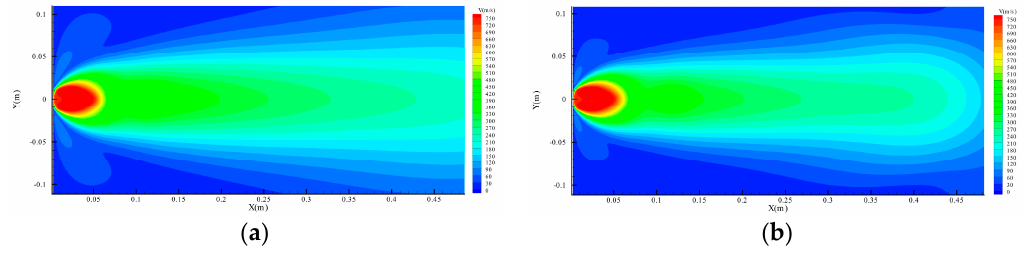
Figure 12. Velocity contour of different external temperature. ( a ) 393 K; ( b ) 173 K.